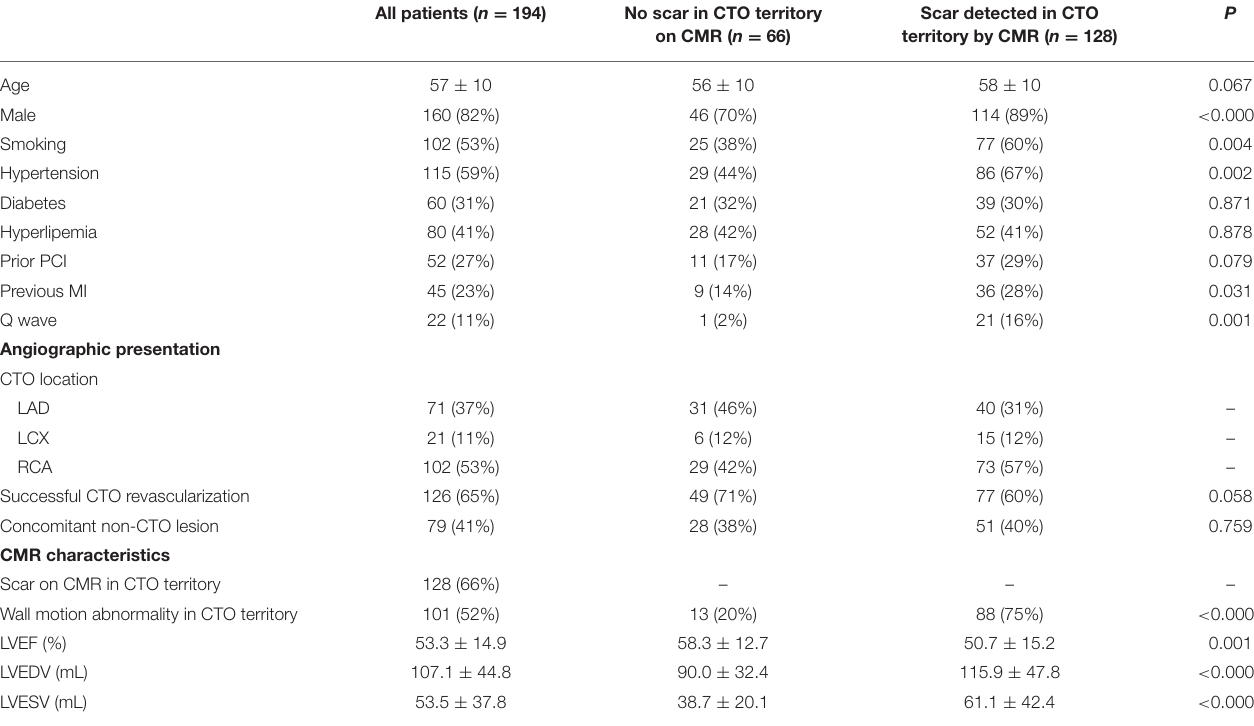
TABLE 1 | Baseline characteristics.